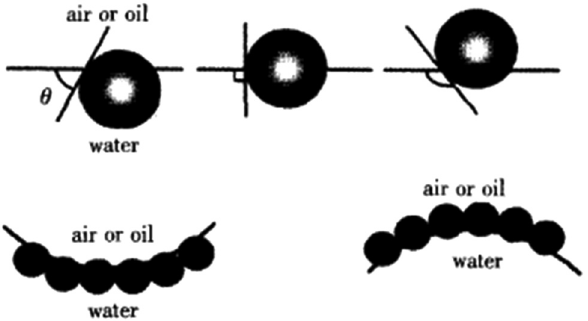
Figure 2: Relationship between wettability of particles and emulsion type [ 36